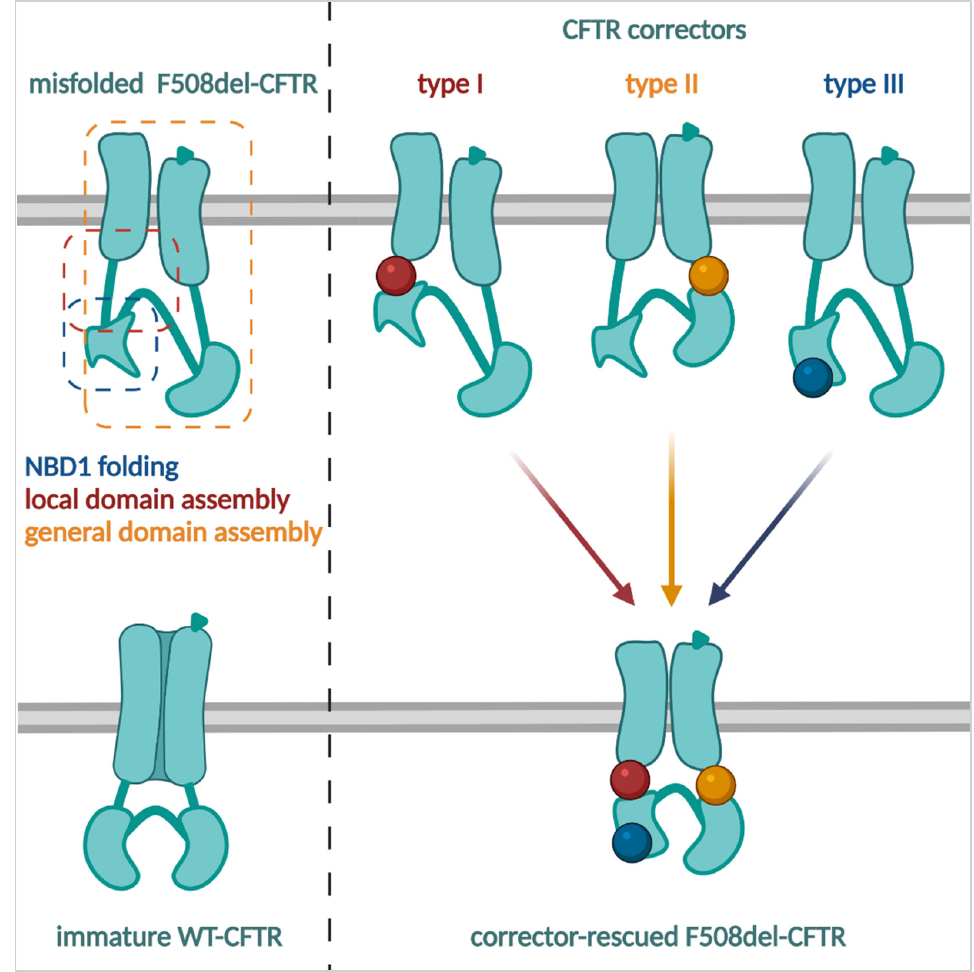
Figure 5. Different types of CFTR correctors. Left: The F508del-CFTR protein is misfolded and does not achieve the native conformation of wild-type (WT)-CFTR. Schematic overview of folding defects associated with the F508del mutation. Right: Type I, II, and III correctors tackle different folding defects, which alone or in combination (partially) rescue F508del to a more WT-like state.